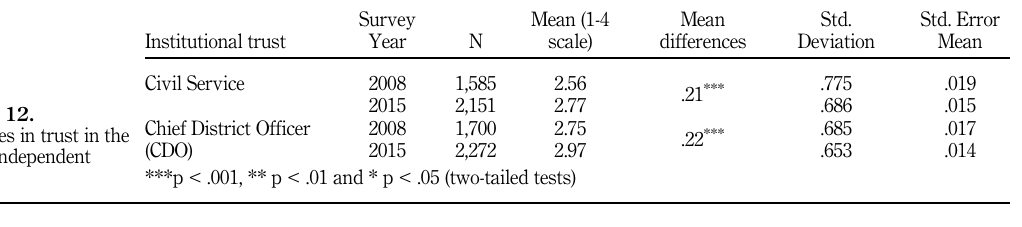
Table 12. Changes in trust in the NCS (Independent